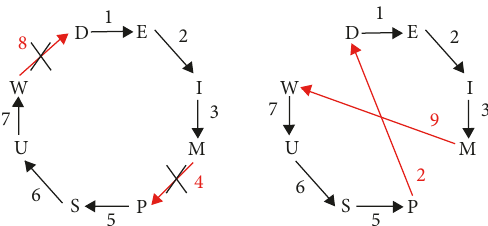
Figure 3: An example of the 2-opt heuristic on eight attractions removesedges (𝑊, 𝐷) and (𝑀,𝑃) , with weights 8 and 4, respectively, and replaces them with edges (𝑀,𝑊) and (𝑃, 𝐷) , with weights 9 and 2, respectively. This 2-opt improves the tour fitness from 36 to 35.